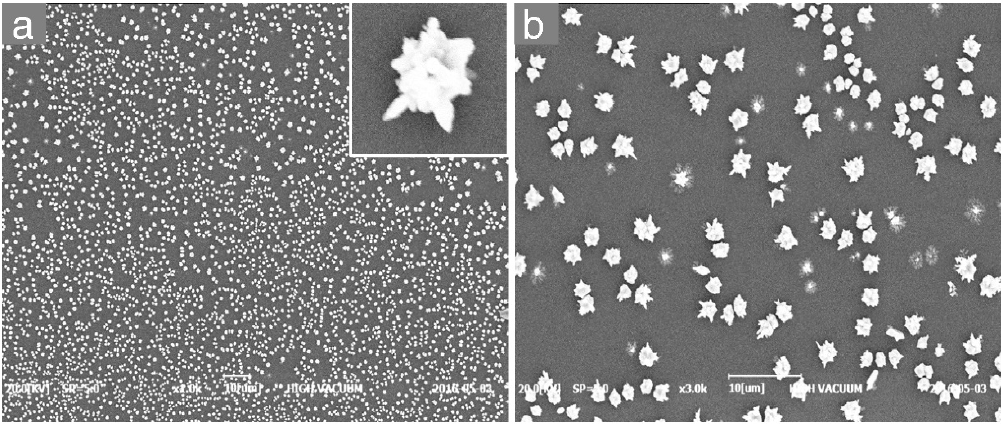
Figure 2. SEM images of ( a ) AgNFs electrodeposited on ITO surface (main) and a single nanoflower (inset), and ( b ) magnified view of the AgNFs shown in ( a ).